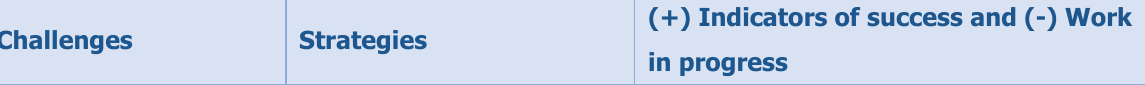
Table 9. Detail, Recognition, and Teamwork—Teens as Teacher Essential